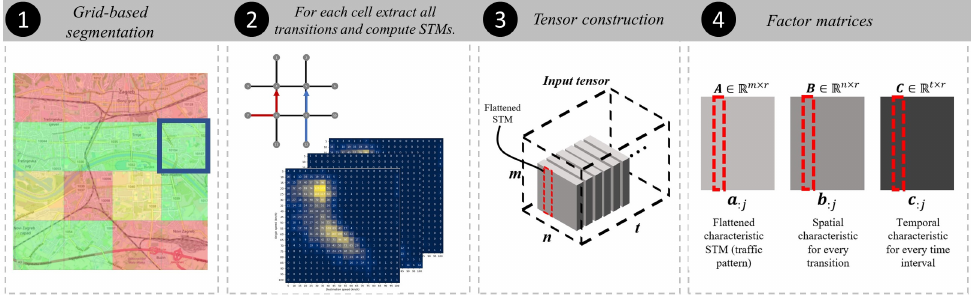
Figure 4. Steps that are describing the tensor construction method using the STMs: ( 1 ) Grid-based map segmentation, ( 2 ) STM extraction, ( 3 ) tensor construction, and ( 4 ) factor